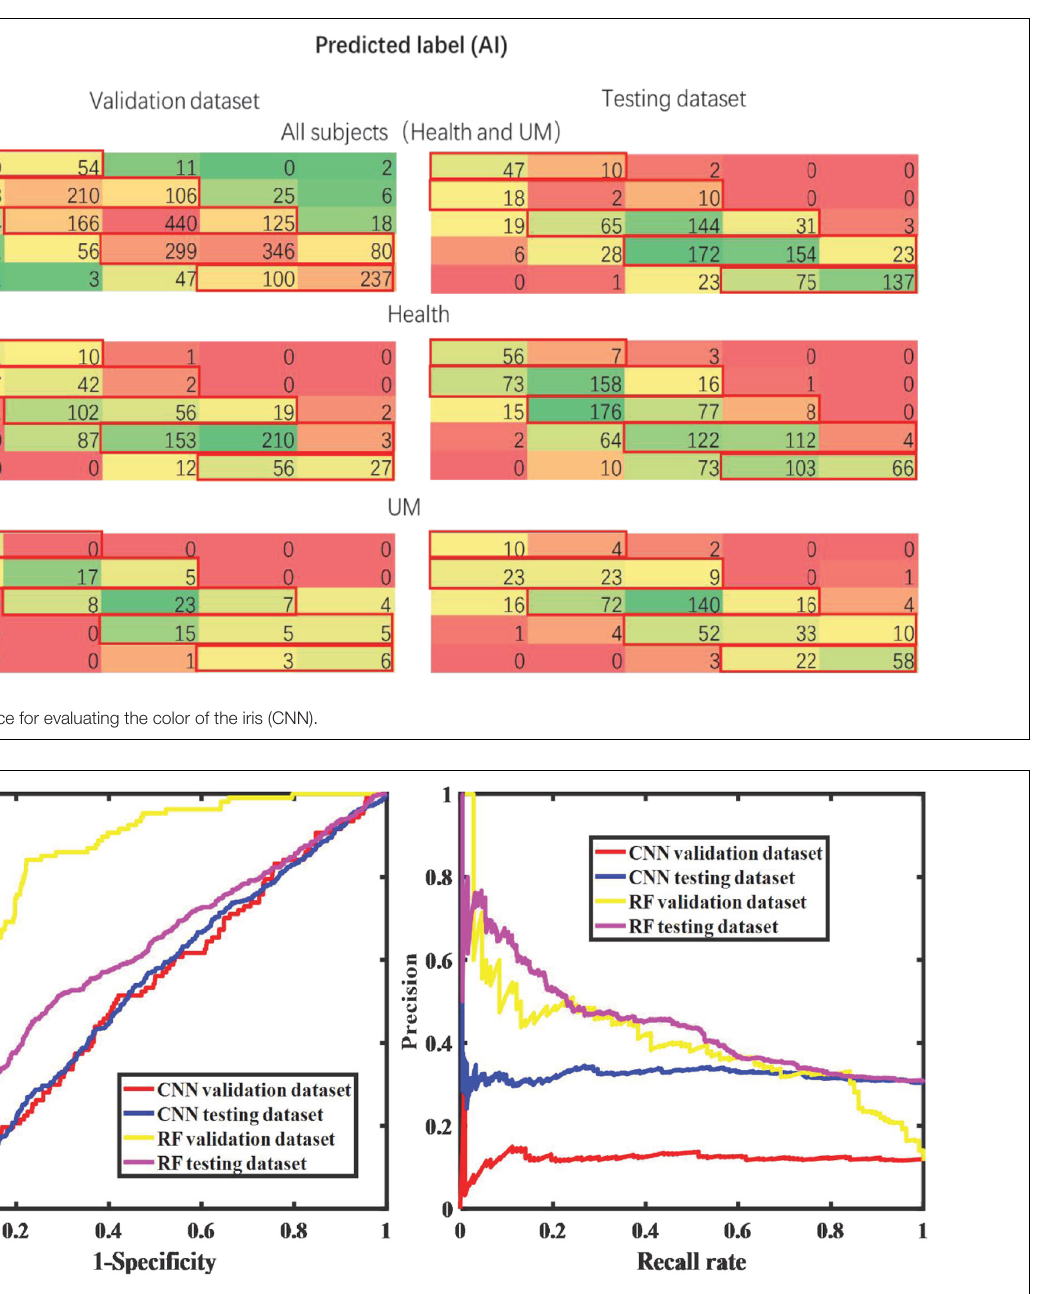
FIGURE 11 | The relationship between the color spectra of the iris and